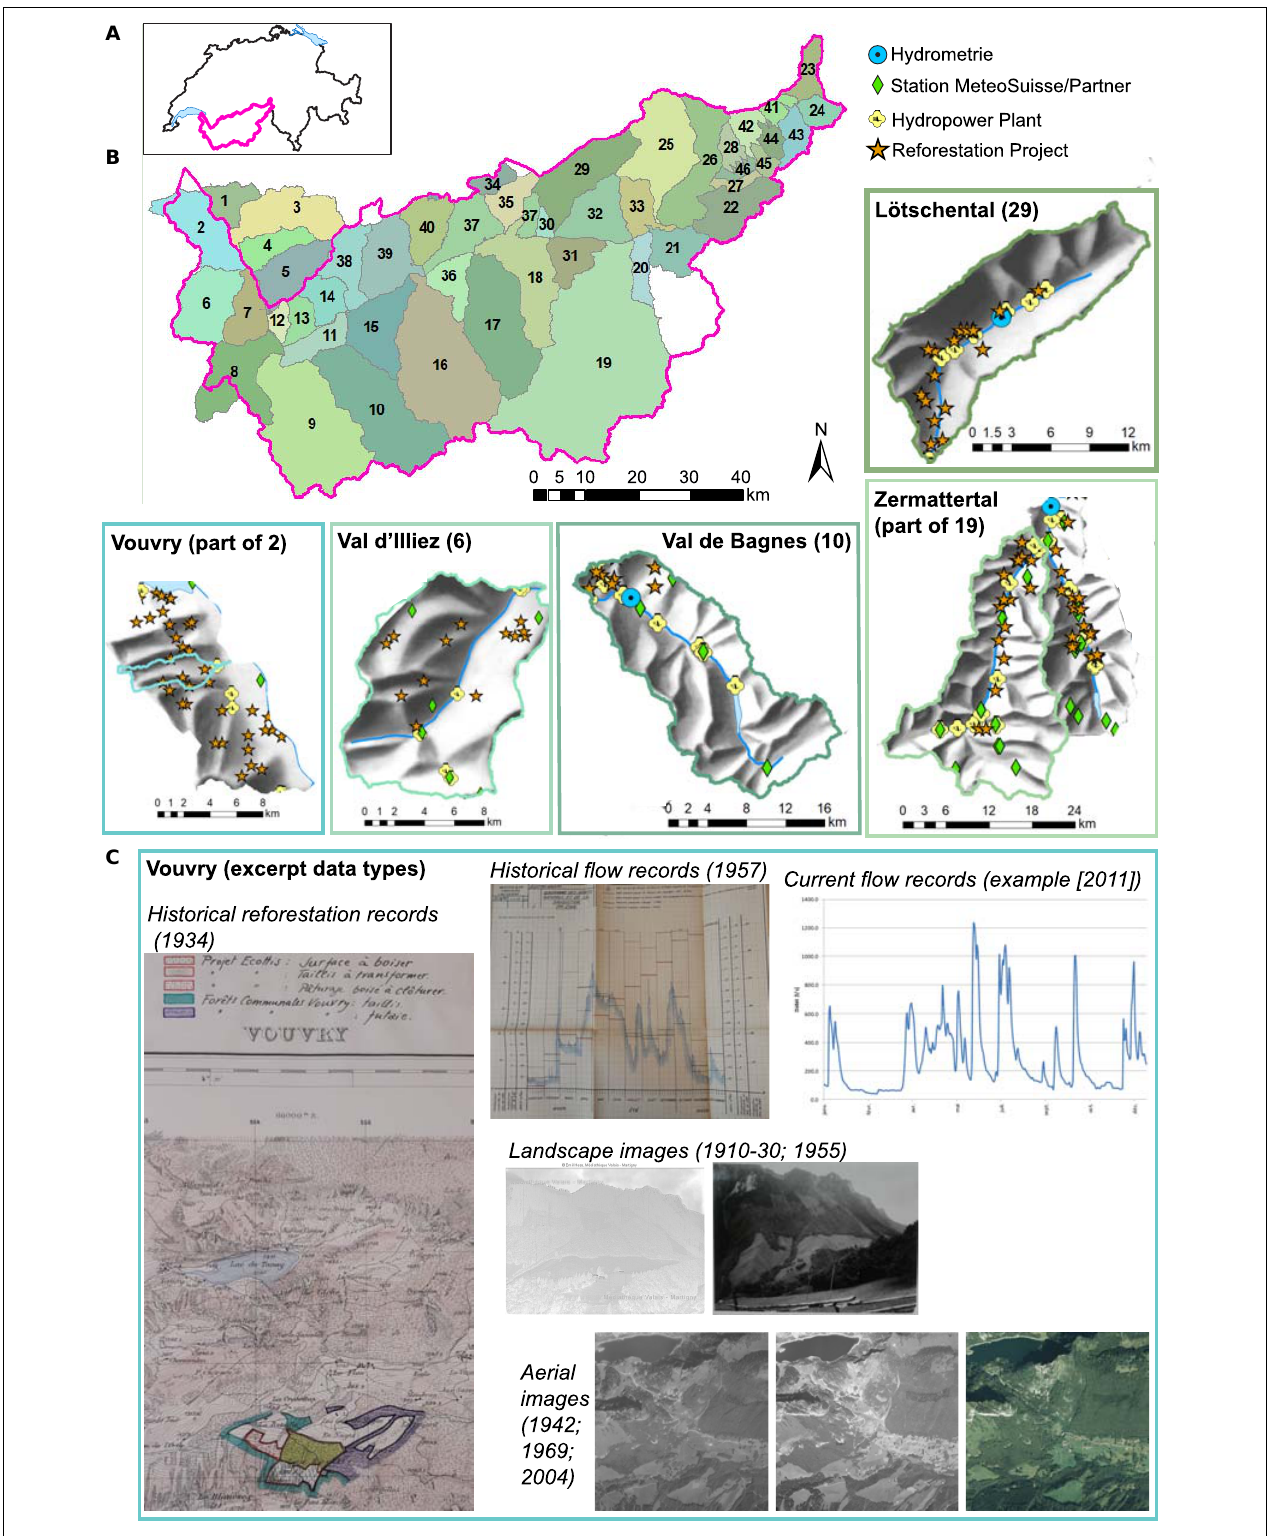
FIGURE 3 | Data types and availability of the case study conducted in the Upper Rhone catchment. Panel (A) shows the canton Valais in relation to Switzerland. Panel (B) shows the delineated regions, with specific details on the five regions selected for further study. Panel (C) shows examples of data types available. For data sources please see the Supplementary Material